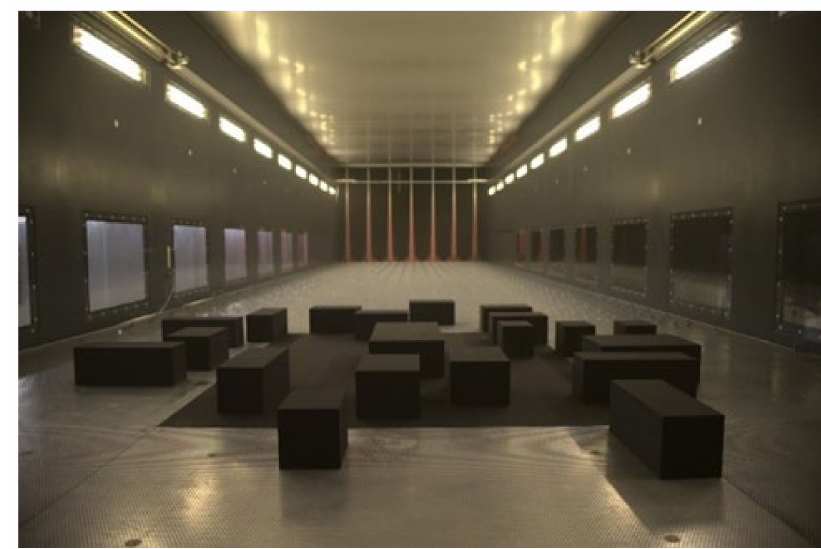
Figure 5. Wind tunnel and obstacle configuration. Two different boundary layer approach flows are modelled at a scale of 1:100 to investigate the influence of the flow on the measurements inside the model area. One boundary layer flow represents the conditions of a “moderately rough” boundary layer.